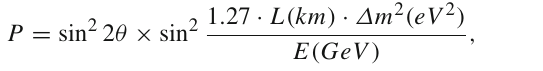
for eV mass scales which require high background